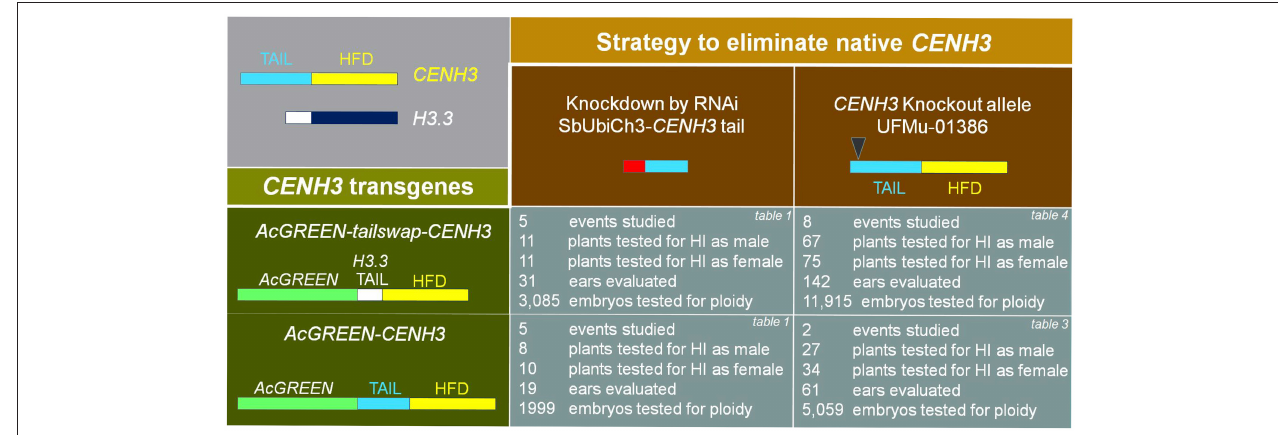
FIGURE 1 | Experimental overview of the four CENH3 complementation strategies tested. Two native CENH3 elimination methods ( top row ) were paired with each of the two transgenes ( left column ). The number of transgenic events studied, plants crossed, and progeny screened for each strategy is shown in the four gray boxes ( bottom right ). In the top right corner of these boxes, the corresponding data table for that box’s strategy is indicated. Not included in this diagram is the experimental design for the control data measuring the background haploid induction rate. The experimental set up for that test is described in the methods, and the data is found in Table 1